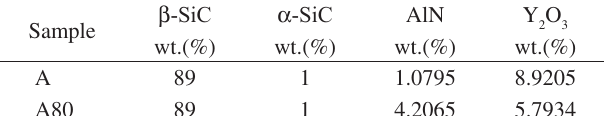
Table 1. Sample designation and composition.